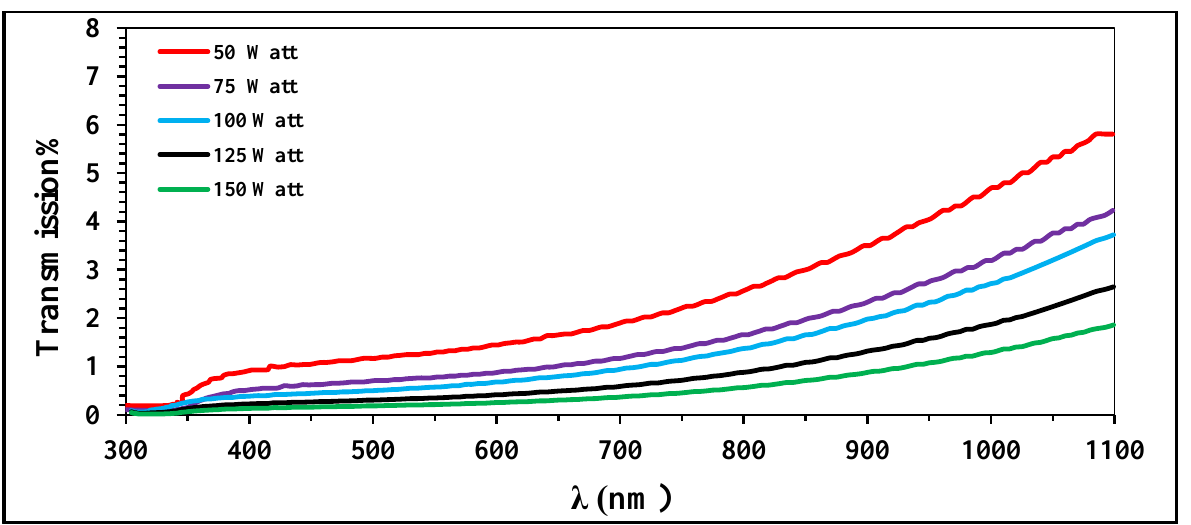
Fig.2: Transmittance as a function of wavelength for (Ti6Al4V) thin film at different working RF